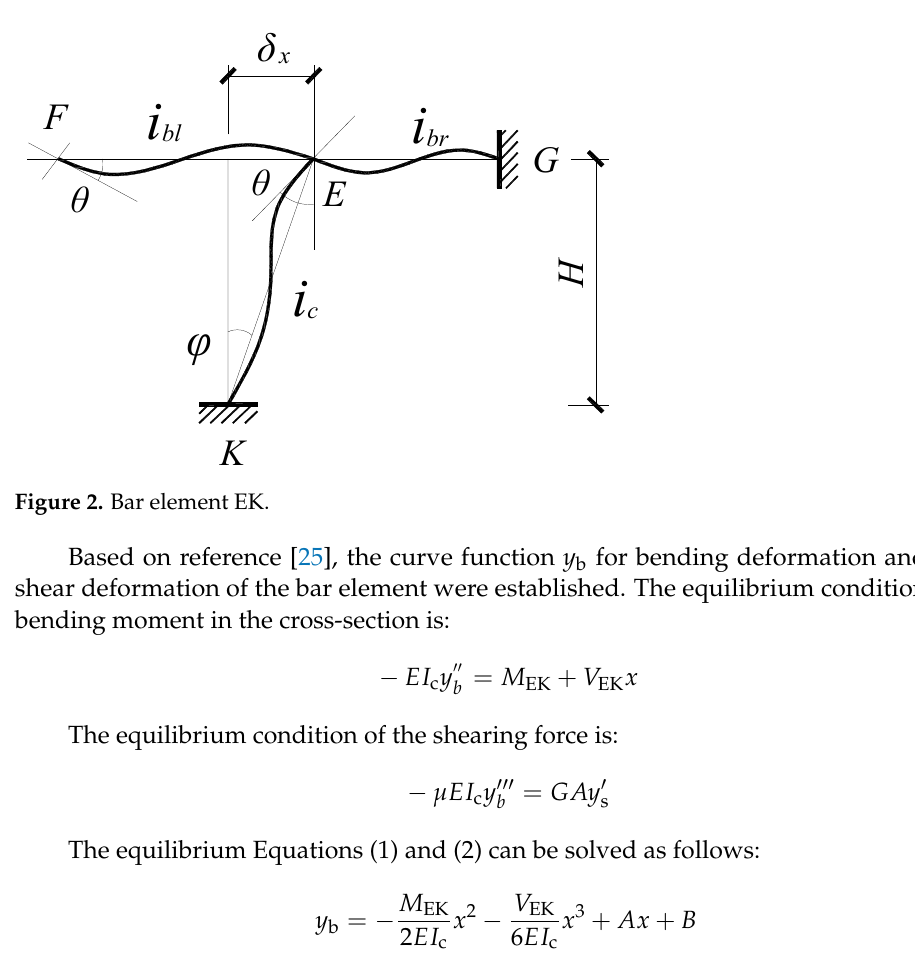
Figure 1. Structural-analysis sketch.